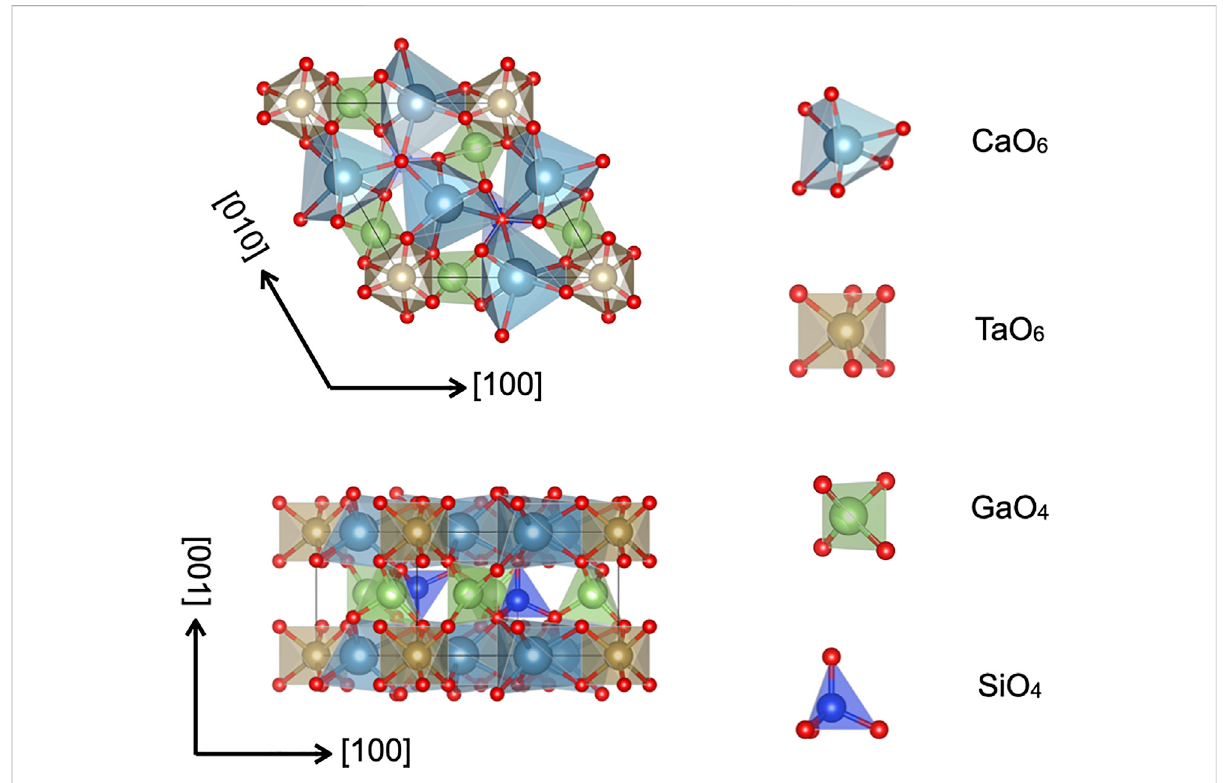
FIGURE 1 Schematic illustration of the crystal structure of